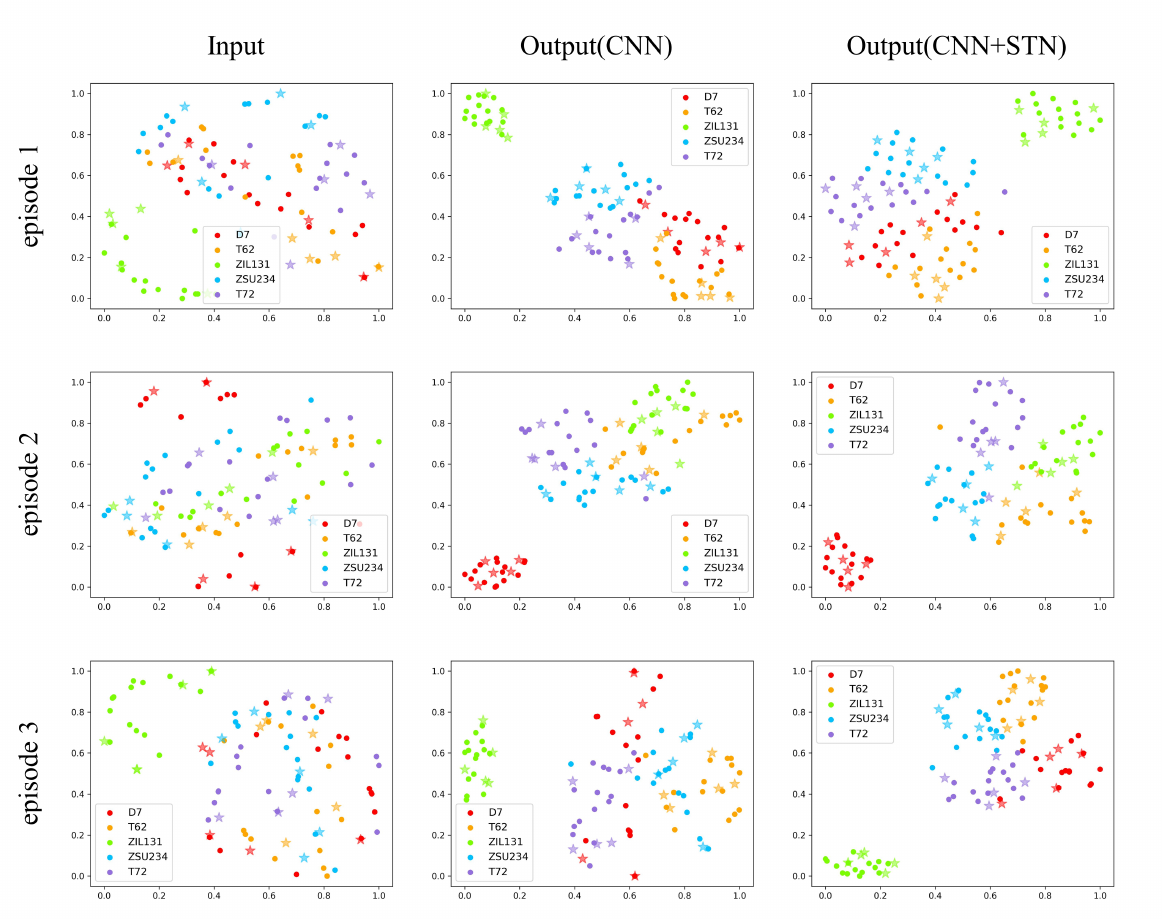
Figure 6. T-SNE visualization results of the whole stages of three individual episodes for five-way dive-shot experiments. Each column denotes a stage and each row denotes an episode. Images in the left column indicate the visualization results of the input, outputs of CNN in the middle, and outputs of STN cascaded after CNN in the right. Note that each solid circle and star of the same color stands for the same